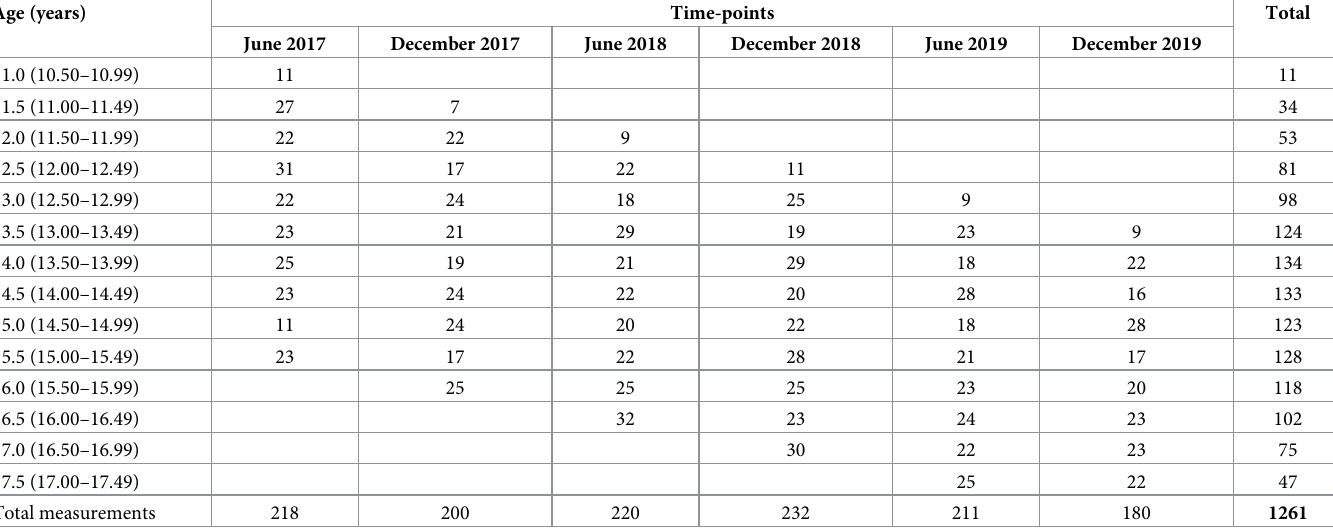
Table 1. Number of measurements per time-point for each age